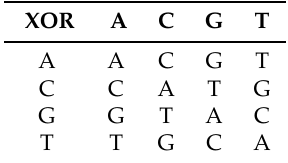
Table 4. XOR operation of DNA